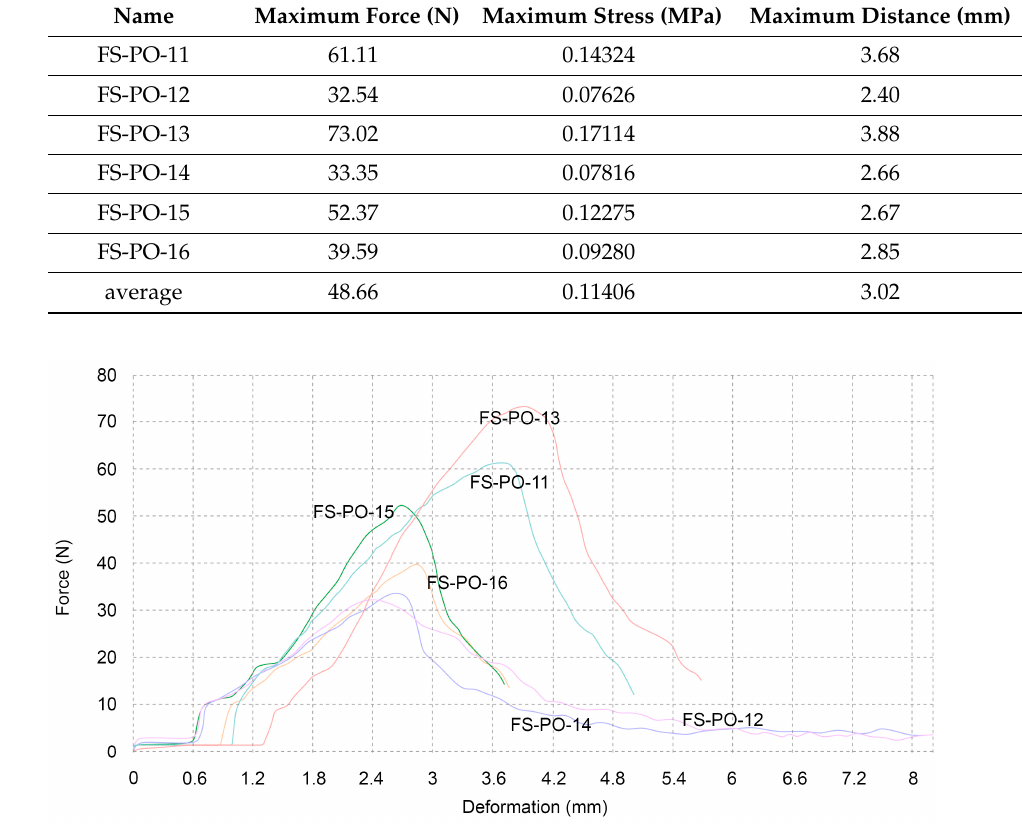
Table 5. Three-point flexural test of various